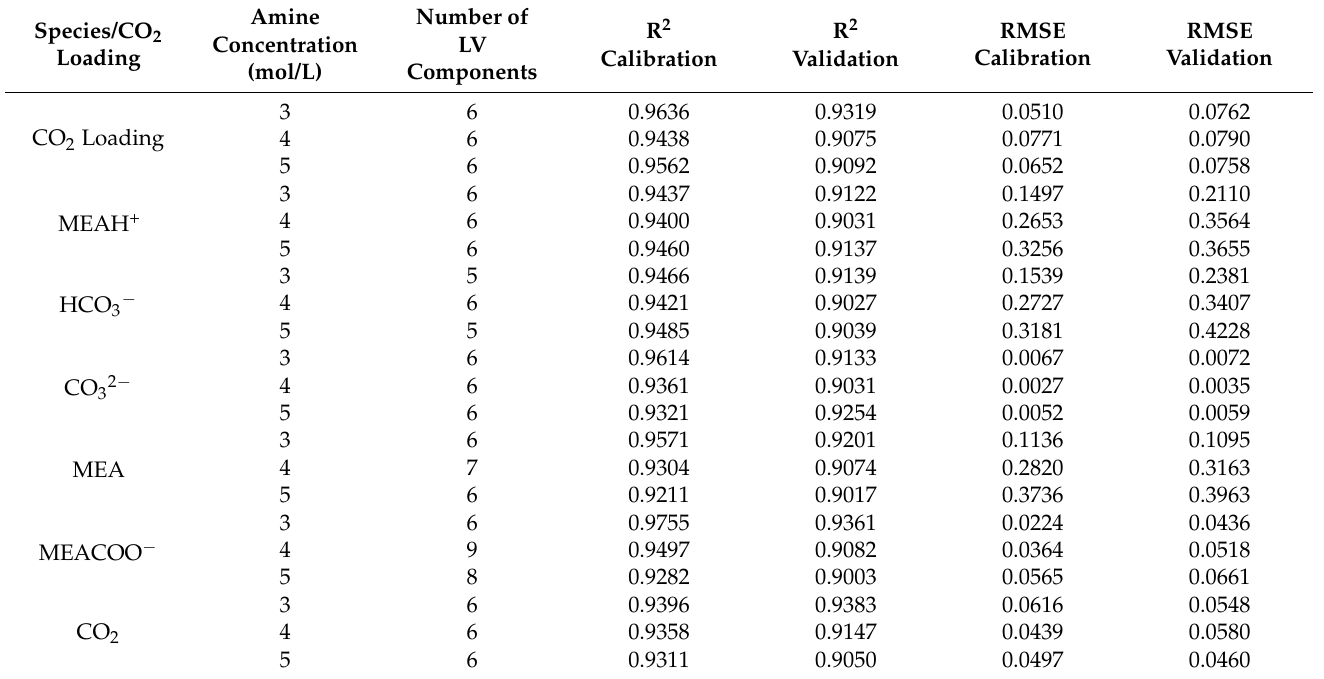
Table 3. Summary of performance evaluation results for PLS-based Raman species calibration models. Species/CO 2